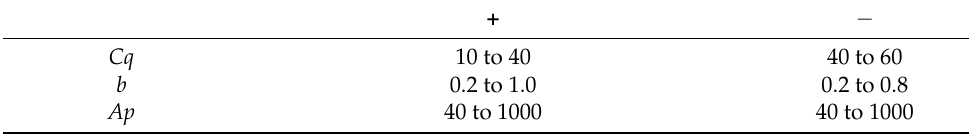
Table 2. Parameters for logistic functions of classes + and − .